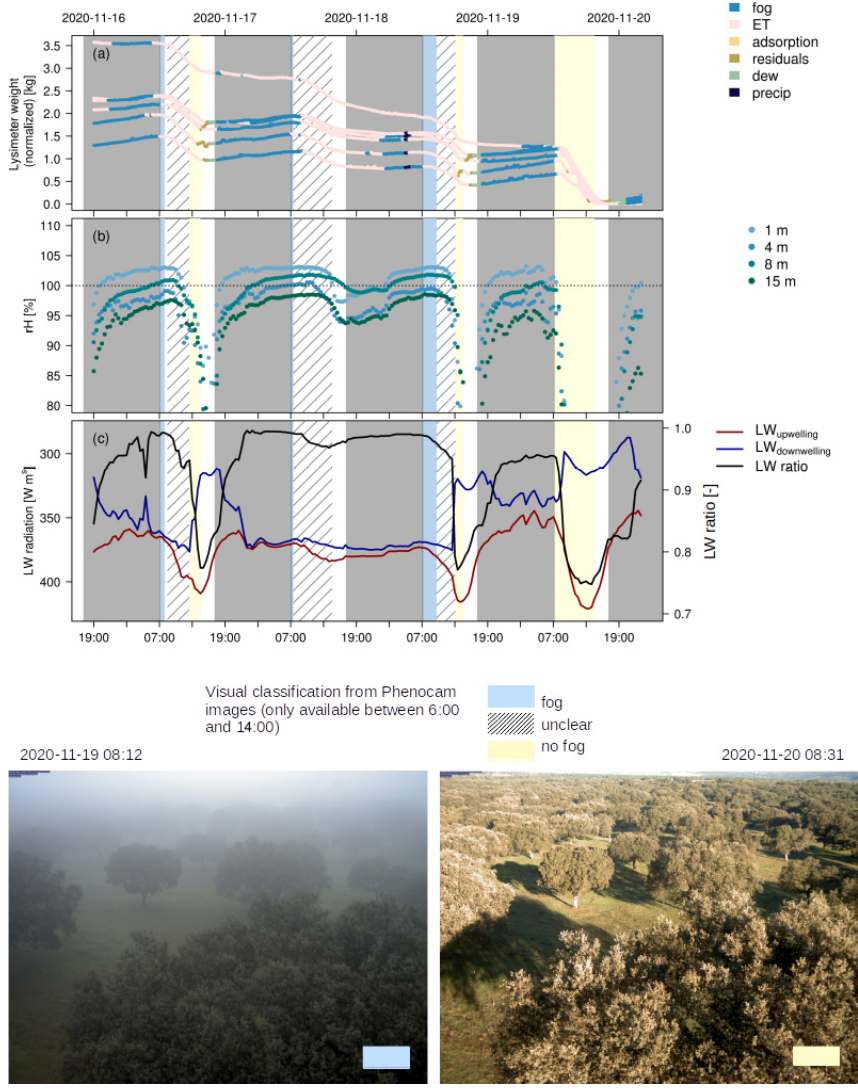
Figure G1. Time series of (a) normalized weight changes in each lysimeter column with the respective assigned fluxes, (b) rH measurements, and (c) LW upwelling and LW downwelling and their respective ratios. Shaded areas illustrate nights (gray), conditions clearly identified as fog from digital camera images (blue; image bottom left), and non-foggy conditions (yellow; image bottom right). Hatched areas are used for periods that could not be unequivocally identified as